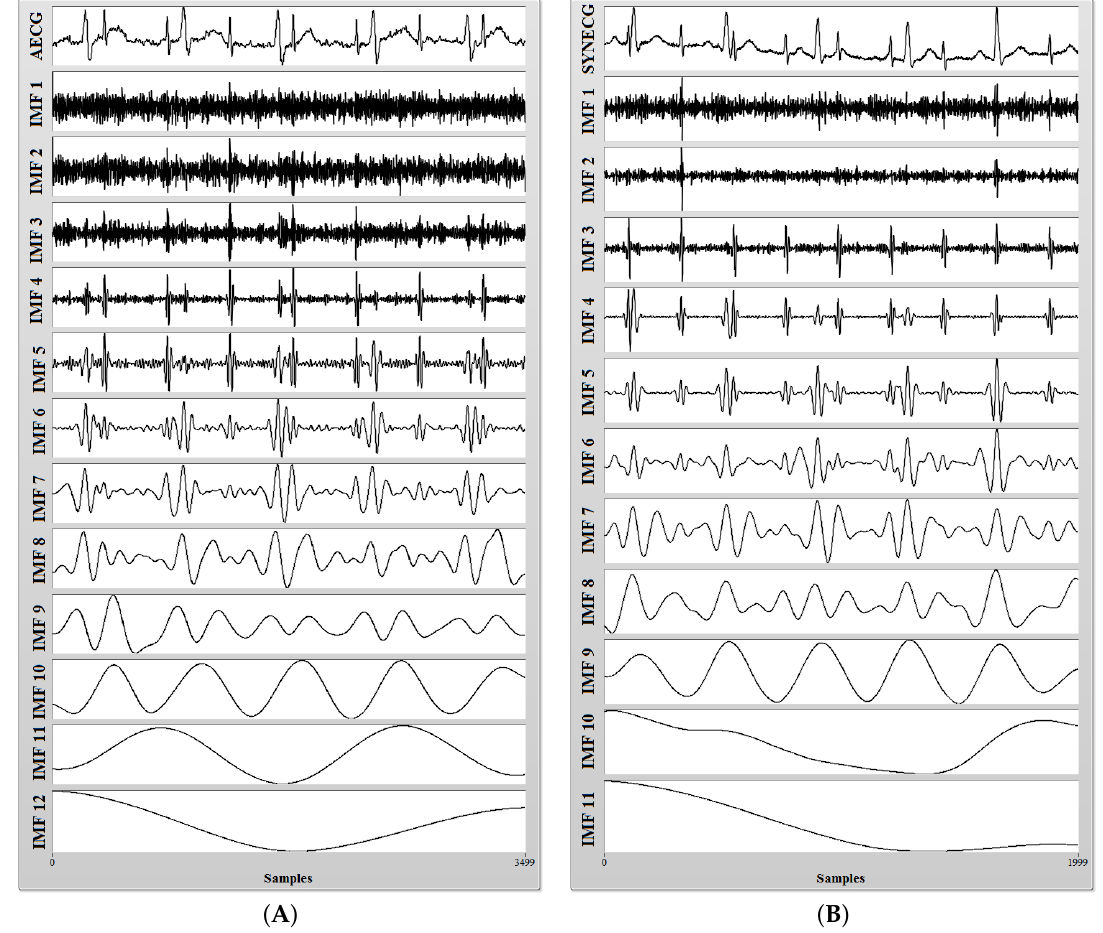
Figure 7. ( A ) A noisy aECG signal (r0104) collected from the PhysioNet database (adfecgdb) (Top) and its 12 IMFs after CEEMDAN decomposition; ( B ) a noisy synthetic aECG signal generated from BPSG (Top) and its 11 IMFs after CEEMDAN